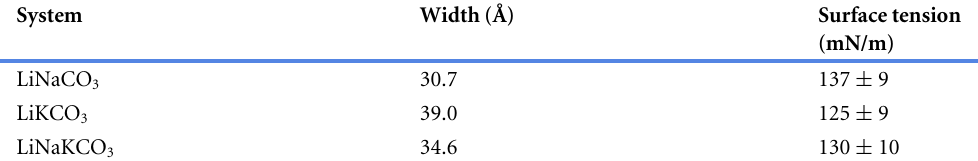
Table 2 Width and surface tension for each of the systems